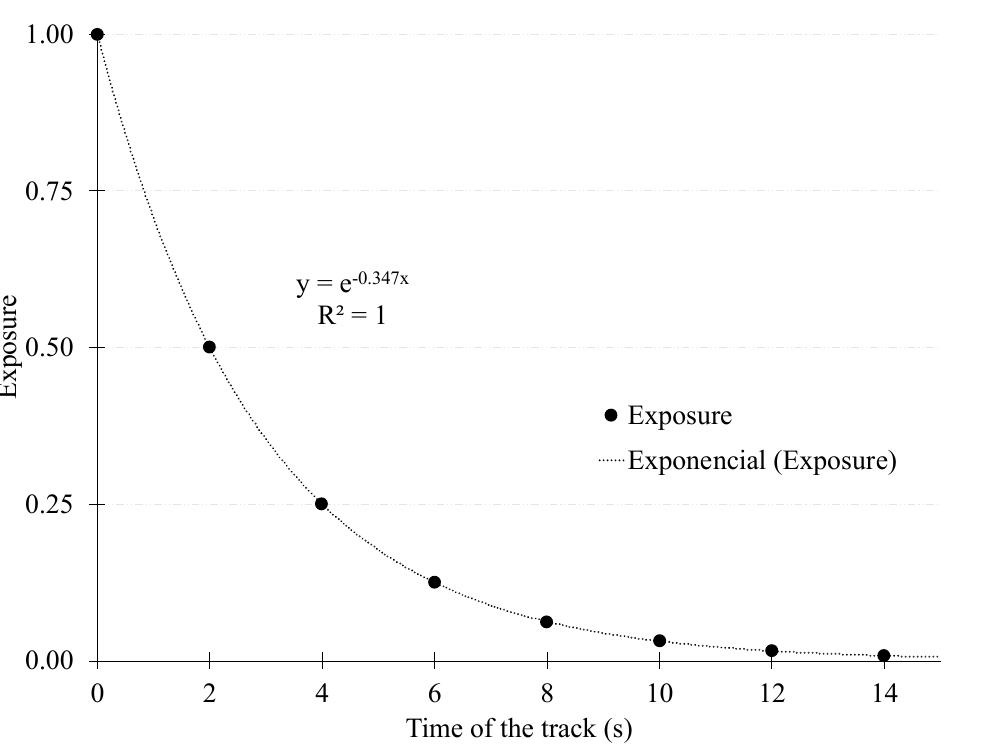
Figure 2. Exponential function calculating the exposure score of the contact with the individuals and their tracks of respiratory droplets. The exposure declines to a half every 2 s. The window for calculation was set between 0 and 15 s, where the exposure score is 0.005. Adapted from Knudsen et al. [17] .